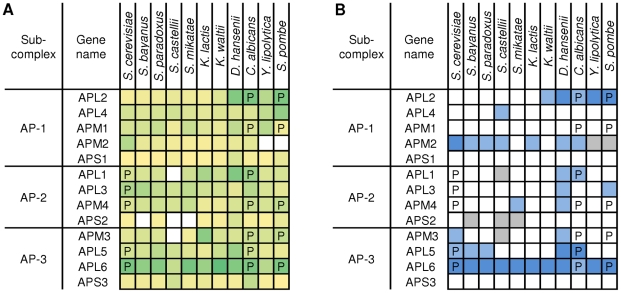
Evolution of phosphoregulation of the Clathrin associated protein complex.
S. cerevisiae, C. albicans, and Sc. pombe proteins found to be phosphorylated experimentally are marked with a “P.” (A) For each protein phosphorylation propensity was predicted based on sequence (see Methods) and represented in a color intensity gradient where darker colors represent increasing predicted phosphorylation likelihood. The AROC value for the prediction of the phosphorylation pattern in the three species is 0.76 using the GPS method. White squares denote lack of predicted ortholog. (B) Casein kinase I type (Yck1p, Yck2p, Yck3p, and Hrr25p) phosphorylation propensity was predicted from sequence and classified as poor (white), weak (light blue), or strong (dark blue). Casein kinase type I phosphorylation propensity predicts this phosphorylation pattern with an AROC value of 0.63. Gray denotes lack of predicted ortholog.